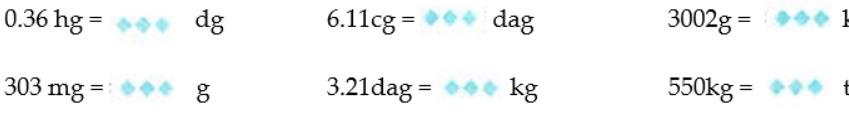
Figure 9. Inter-unit of measure equivalence (sixth year mathematics, SM [49]).